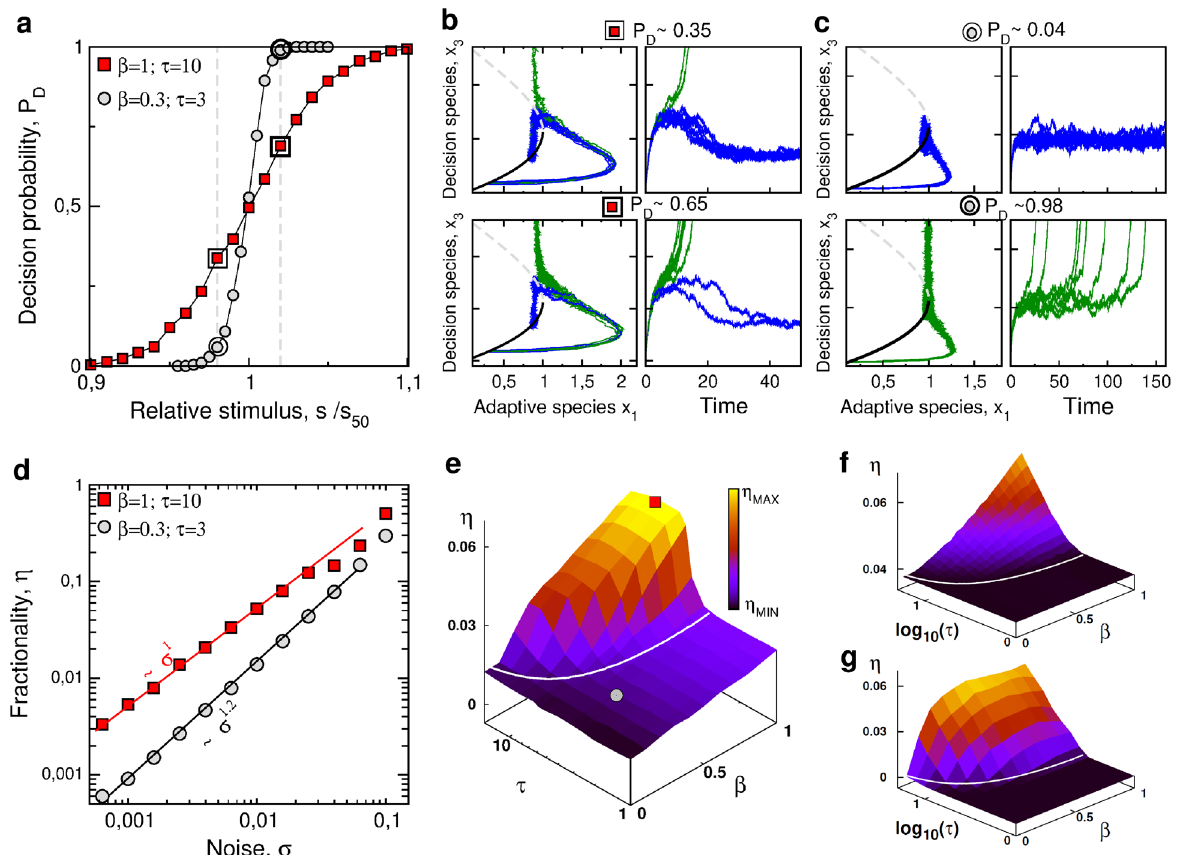
Figure 3. The critical impact of adaptation on cell-fate heterogeneity. Fate decision probability is studied in presence of molecular noise level ( a – e ) or other sources of cell-cell variability ( f – g ). ( a ) Fate probability curves as function of relative stimulus for the cases of strong/slow adaptation (red squares) and weak/fast adaptation (gray circles). ( b – c ) Sample of noisy single-cell trajectories associated with a ± 2% change of stimulus level around s = s 50 (dashed line of panel a ), which are plotted in the { x 1 , x 3 } state space where steady-state branches (cid:31) x ( s ) are also represented. ( d ) Fractionality index η as function of noise with their asymptotic scaling exponents. ( e ) Fractionality index η as a function of adaptation parameters τ and β for molecular noise level σ = 0.01 . White line delimits the parameter domains of saddle-collision and saddle-node transition scenario (redrawn from Fig. 2c). Red squares ( β = 1 and τ = 10 ) and grey circles ( β = 0.3 and τ = 3 ) correspond to the two archetypical parameter sets associated to each scenario, which are compared in panels a – d . ( f – g ) Fractionality index η as function of β and τ for two sources of cell-cell variability: ( f ) a uniform distribution of stimulus ′ � = 0.01 δ 0 ) + � δ x with exposure s l with � δ s l δ s l l , l ′ ; ( g ) a uniform distribution of initial conditions � x st 1 ( s = � δ x l � = 0.1 δ i , j δ l , l ′ δ x l ′ j i